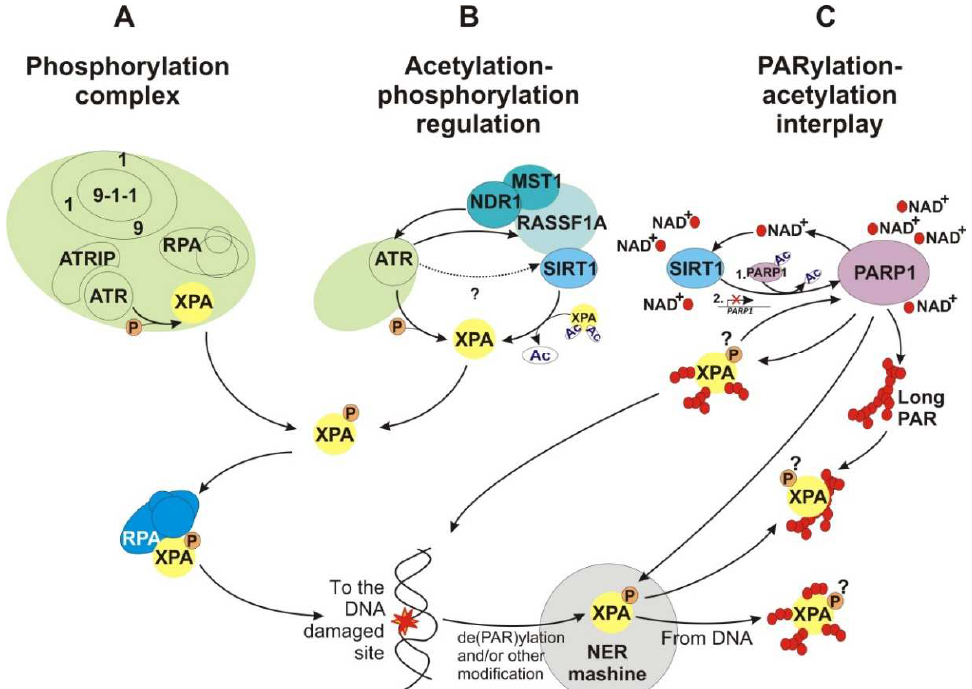
Figure 7. The network of reciprocal regulatory mechanisms of XPA’s PTMs. ( A ) The putative phos- phorylation complex. ATR phosphorylates XPA at S196. ( B ) Acetylation–phosphorylation regulation. XPA is acetylated at Lys63 and Lys67. SIRT1 promotes NER by deacetylating XPA. The existence of an ATR–SIRT1 interaction is unclear and is indicated by the question mark. ( C ) PARylation–acetylation interplay. XPA is PARylated by PARP1. Both PARP1 and SIRT1 use NAD + for their activity and interact physically. There is a strong connection between acetylation and PARylation. SIRT1 may deacetylase PARP1 and inhibit the PARP1 enzymatic activity. Under severe stress, PARP1 can become overactivated and may deplete cellular NAD + , thereby leading to the repression of SIRT1 activity and suppressing SIRT1 transcription. To prevent this situation, SIRT1 is also capable of negatively regulating the expression of the PARP1 gene. Moreover, XPA has a high affinity for long PAR poly- mers. Whether the PARylation events involve phosphorylated XPA is unclear and is denoted by the question